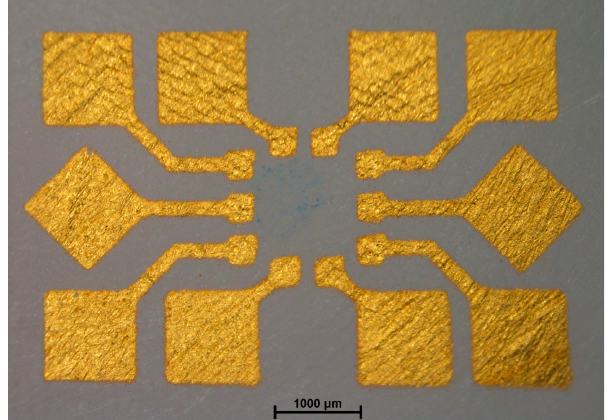
Figure 7. Aerosol jet printed Ag structures (ink: Sicrys I30 EG-1) on 3D ear mold substrate after electroless copper plating on Fototec DLP A ( a ) and Luxaprint 3D mold ( b ).